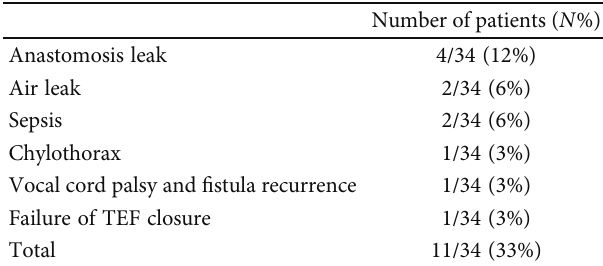
Table 4: Immediate post-operative complications (one patient who was not operated was excluded).